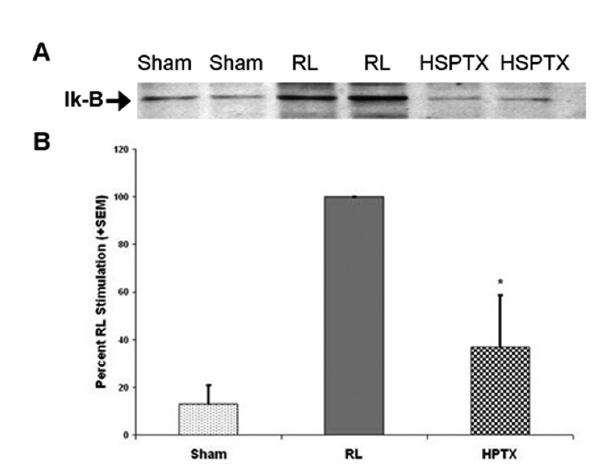
Figure 1 - Cytoplasmic I- κ B α Phosphorylation. A, Representative western blot of phosphorylated cytoplasmic I- κ B α at 4 hours after hemorrhagic shock and resuscitation. The image displays two representative animals from each experimental group. B, Histogram illustrating the 63% increase in phos- phorylation of I- κ B α when RL, rather than HSPTX, was administered after shock. The graph presents changes in the mean density for n = 5-7 animals per group. *, p < 0.043 vs.